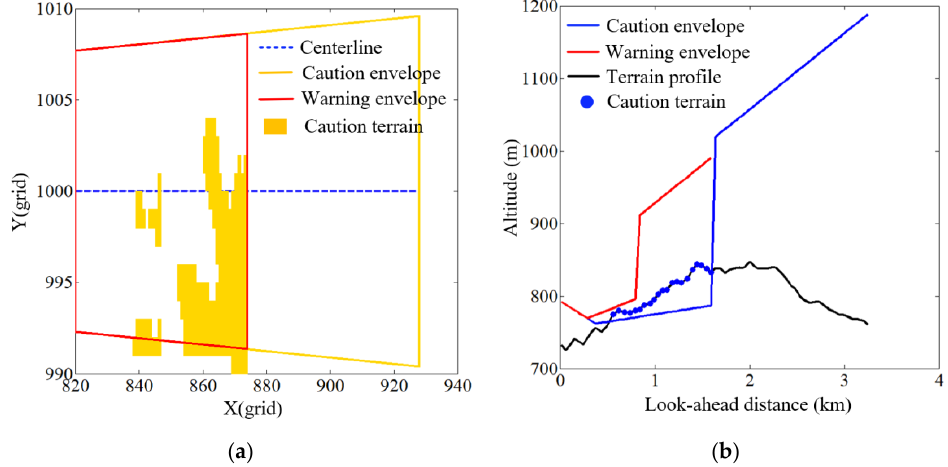
224 Table 1. The RFLTA alert results under different alert types.